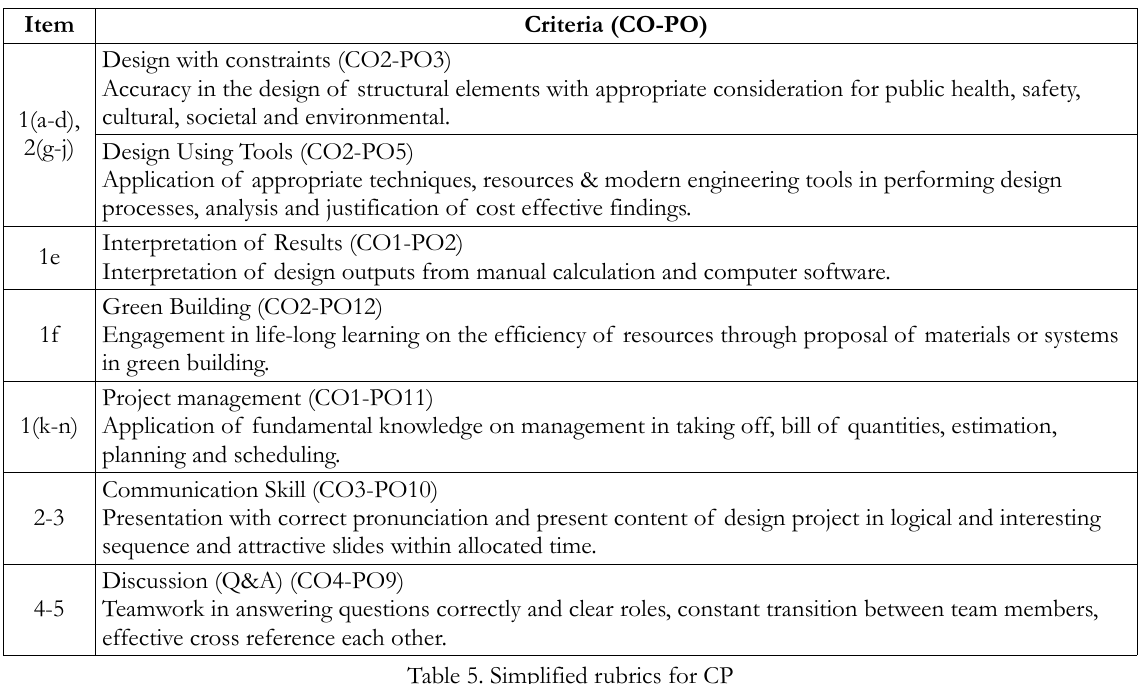
Table 5. Simplified rubrics for CP